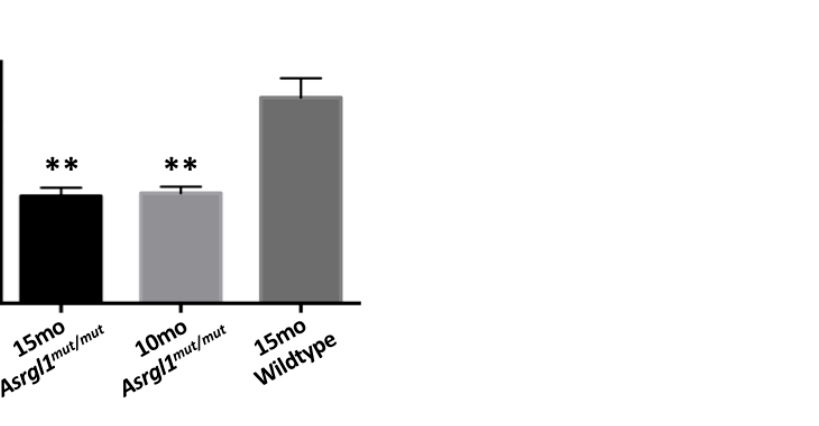
Figure 6. Asparaginase activity in retinal tissue: asparaginase activity detected in 10- and 15-month-old Asrgl1 mut/mut mice retina was significantly lower ( p < 0.0001) compared with the activity observed in 10-month-old wildtype mice. The p value < 0.01 is indicated with **.